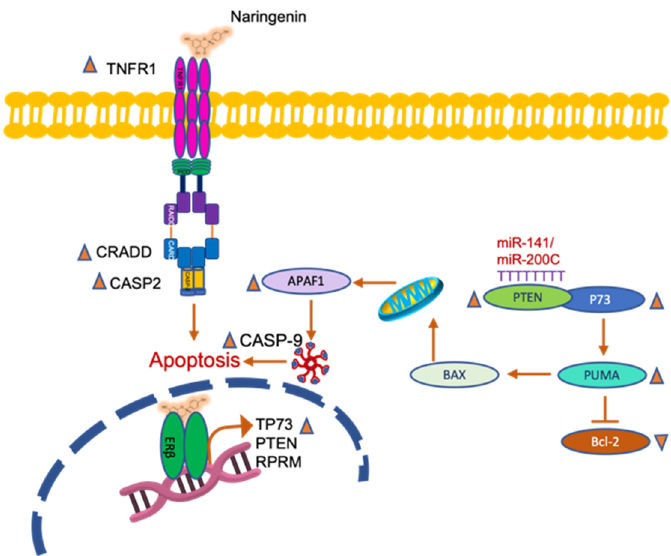
Figure 9. Extrinsic and intrinsic apoptosis by naringenin treatment.